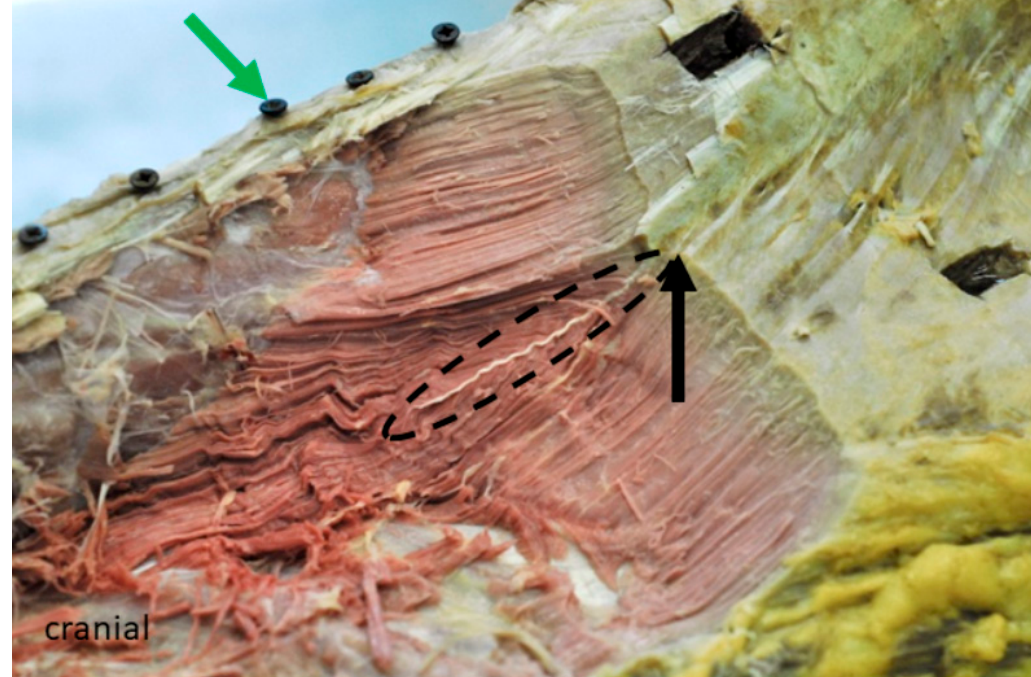
Figure 3. Left cranio-lateral view of a formalin-fixed horseback, showing the partly dissected lumbar LG at the height of the 16th rib (compartment C ). The green arrow is pointing at a screw drilled into the spinous process of the 15th thoracic vertebra, serving as a reference point during computed tomography (CT) scan and digitisation process. Muscle layers have been ablated from cranial to caudal to expose MFB from their origin to the insertion. The strong aponeurosis releases a fascia (black arrow) that divides the muscle partly into a supra- and subfascial belly.